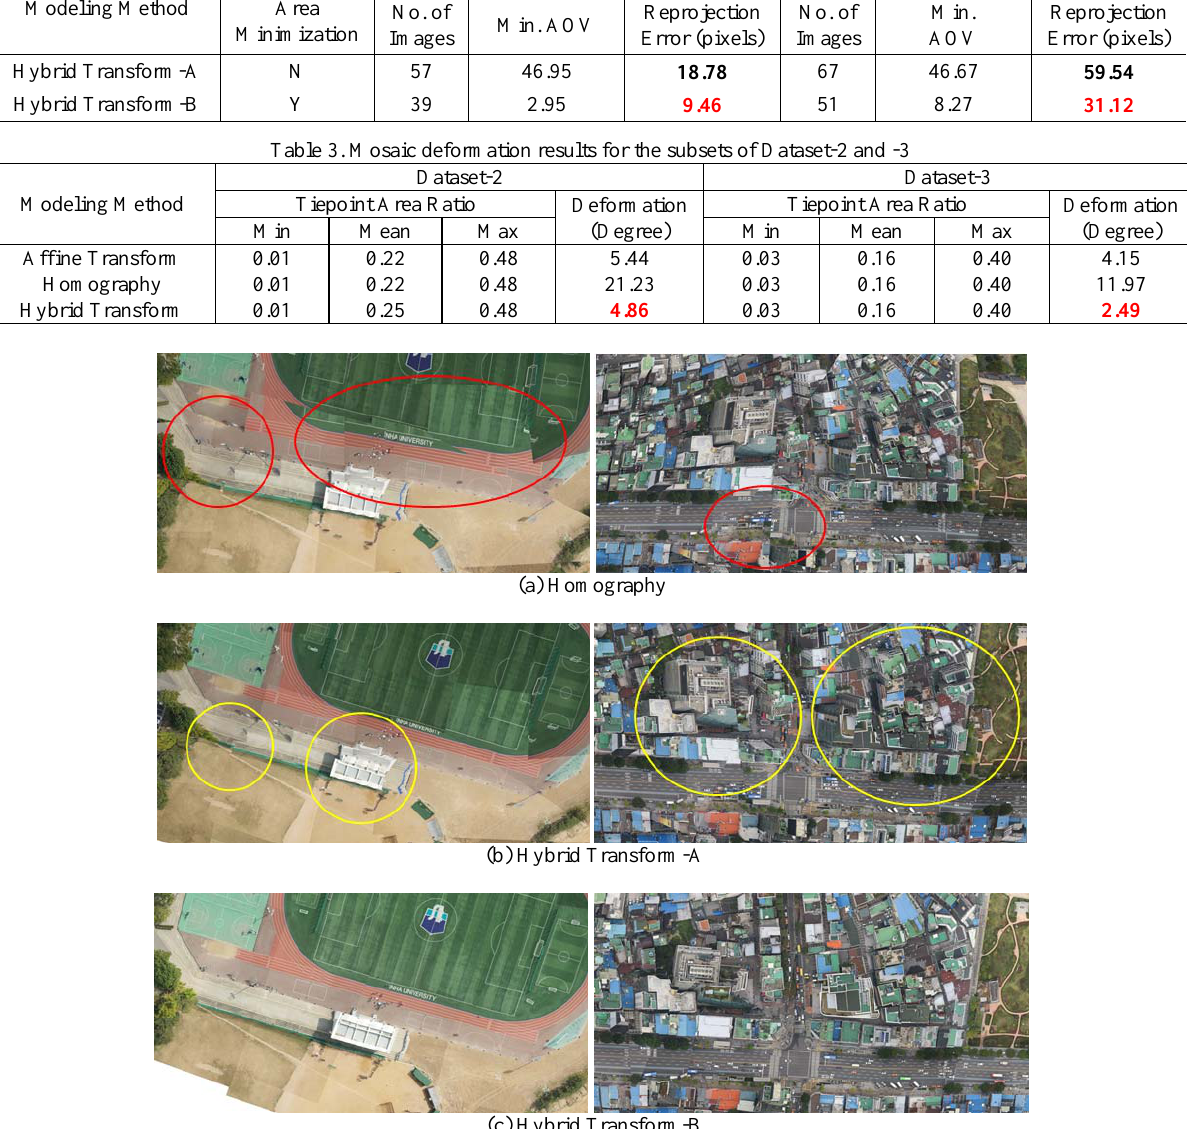
Table 2. Comparison of transformation estimation accuracy by applying composite area minimization.